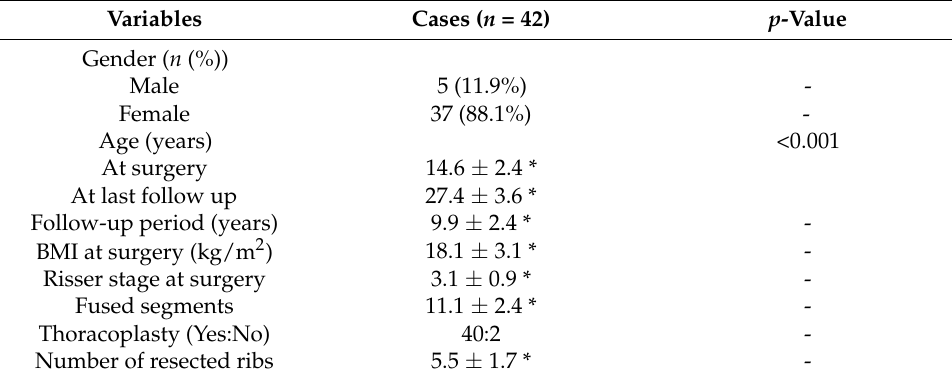
Table 1. Demographic and operative data of this study.